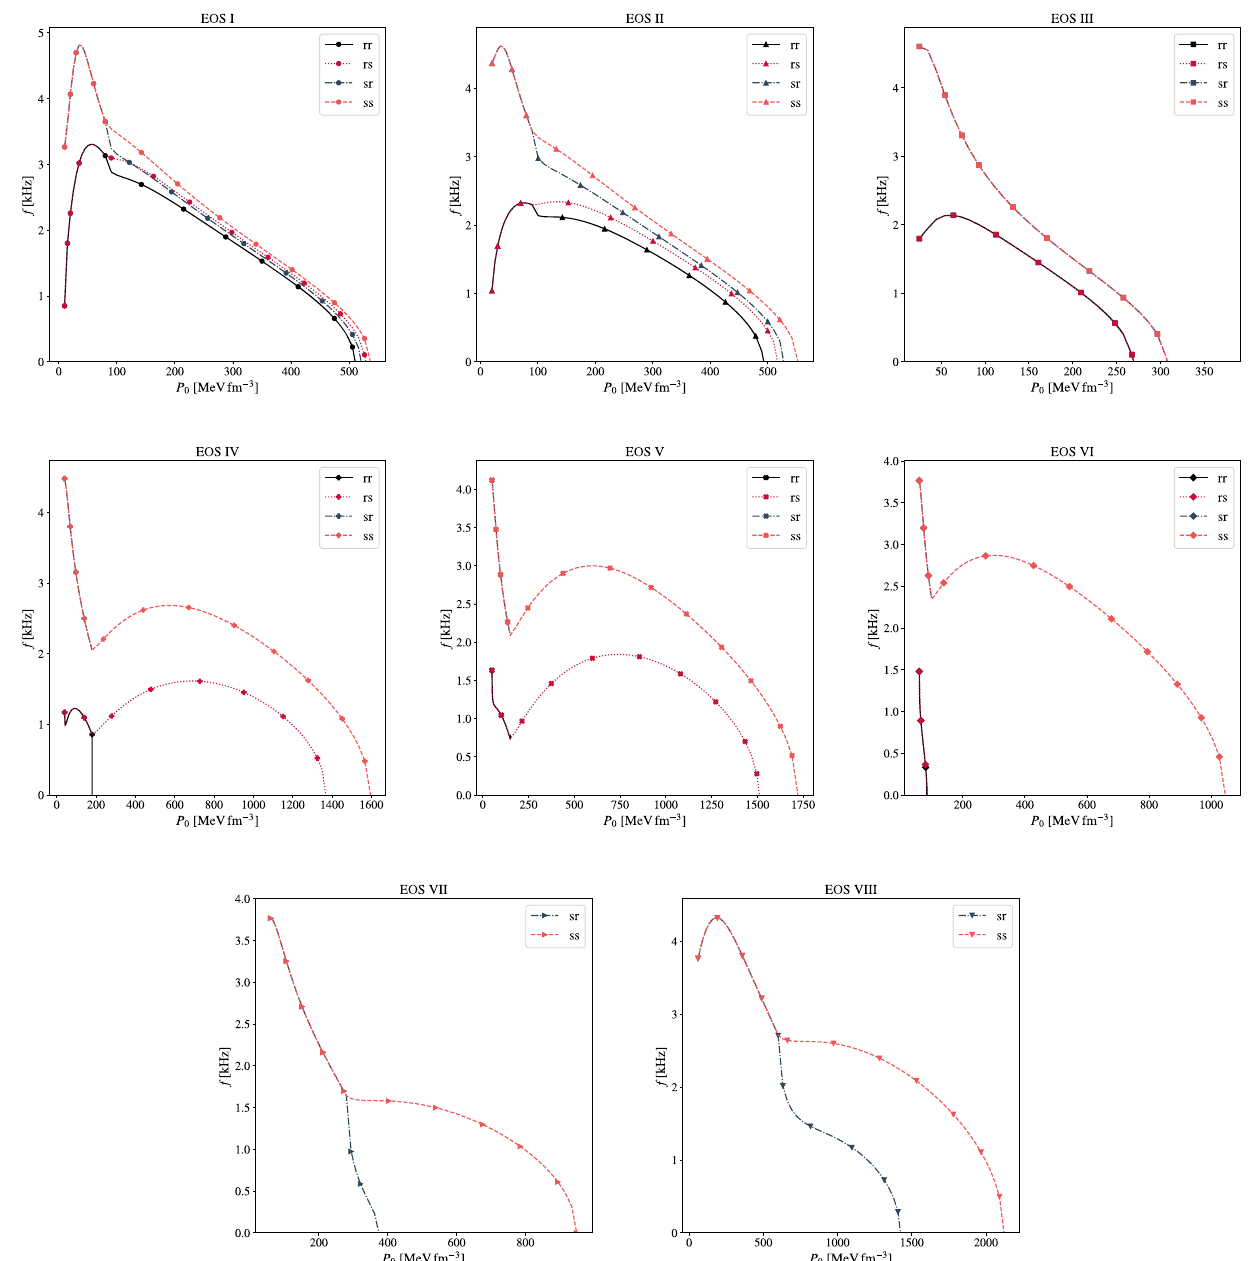
Fig. 3 Fundamental linear eigenfrequency as a function of central pressure, for all models considered and for the different combinations of transition